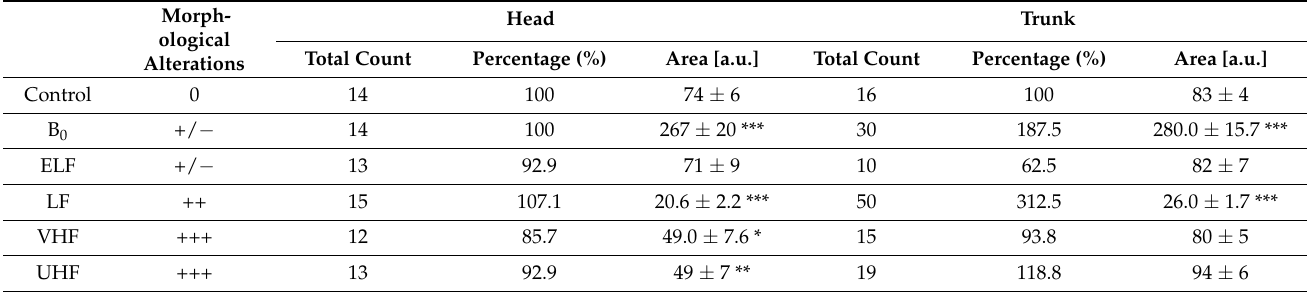
Table 2. Effects of magnetic field irradiations on zebrafish melanophores. With + and/or—we